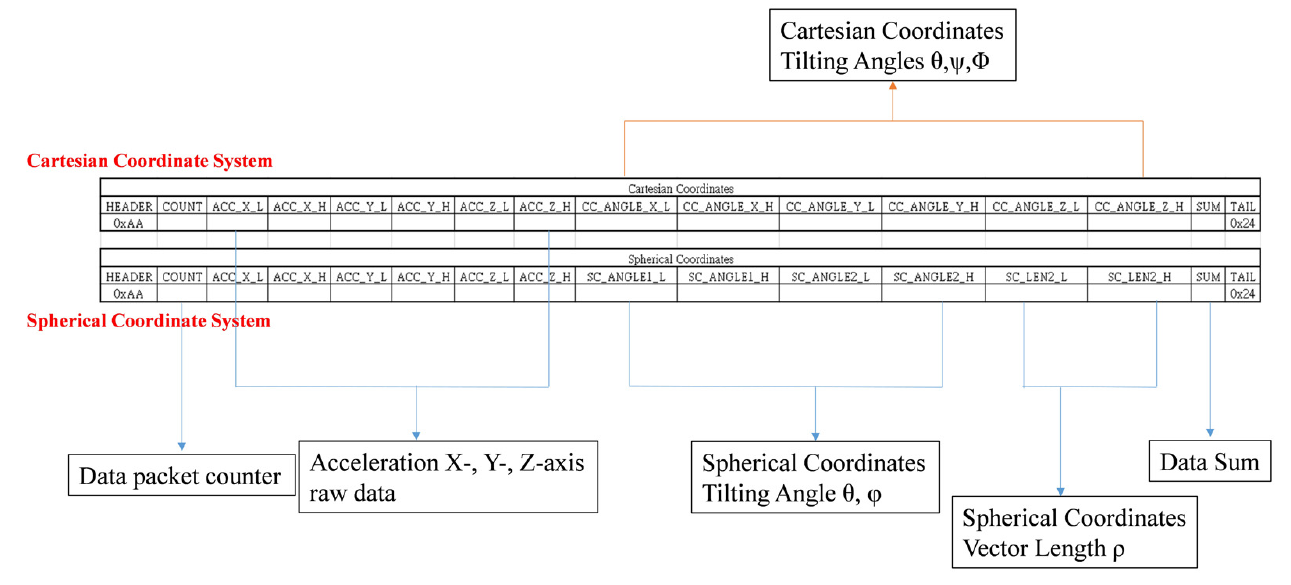
Figure 5. Data packet format of the BASIC module.